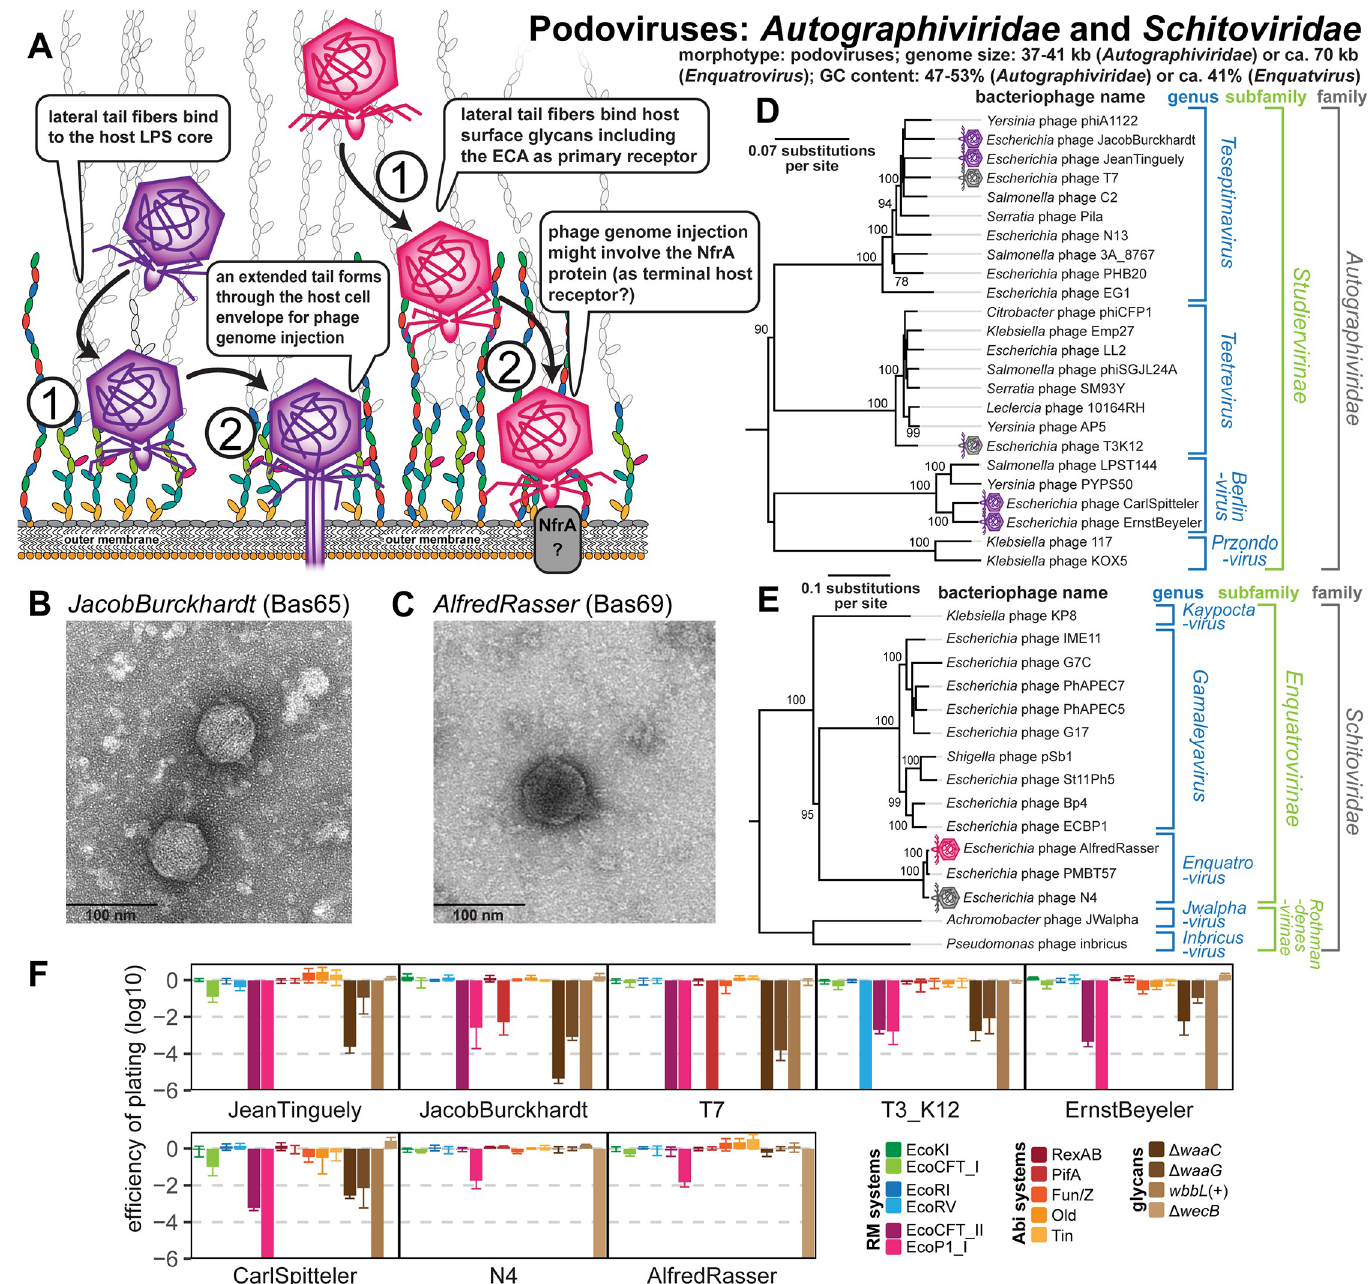
Fig 9. Overview of Autographiviridae subfamily Studiervirinae and Schitoviridae subfamily Enquatrovirinae. (A) Schematic illustration of host recognition by the studied Autographiviridae and Schitoviridae phages. (B) Representative TEM micrograph of T7-like Autographiviridae phage JacobBurckhardt (Bas65). (C) Representative TEM micrograph of Enquatrovirus AlfredRasser (Bas69). (D) Maximum-Likelihood phylogeny of the Studiervirinae subfamily of Autographiviridae based on several core genes with bootstrap support of branches shown if > 70/100. The phylogeny was midpoint-rooted between the clade formed by Teseptimavirus and Teetrevirus and the other genera. Phages of the BASEL collection are highlighted by little phage icons. (E) Maximum-Likelihood phylogeny of the Enquatrovirus genus and related groups of Enquatrovirinae and other Schitoviridae based on several core genes with bootstrap support of branches shown if > 70/100. The phylogeny was midpoint-rooted between the distantly related Jwalphavirus and Inbricusvirus genera and the other shown Schitoviridae. Phages of the BASEL collection are highlighted by little phage icons. (F) The results of quantitative phenotyping experiments with Autographiviridae and Schitoviridae phages regarding sensitivity to altered surface glycans and bacterial immunity systems are presented as EOP. Data points and error bars represent average and standard deviation of at least 3 independent experiments. Raw data and calculations are available in S1 Data. Abi, abortive infection; BASEL, BActeriophage SElection for your Laboratory; ECA, enterobacterial common antigen; EOP, efficiency of plating; LPS, lipopolysaccharide; RM, restriction–modification; TEM, transmission electron microscopy.